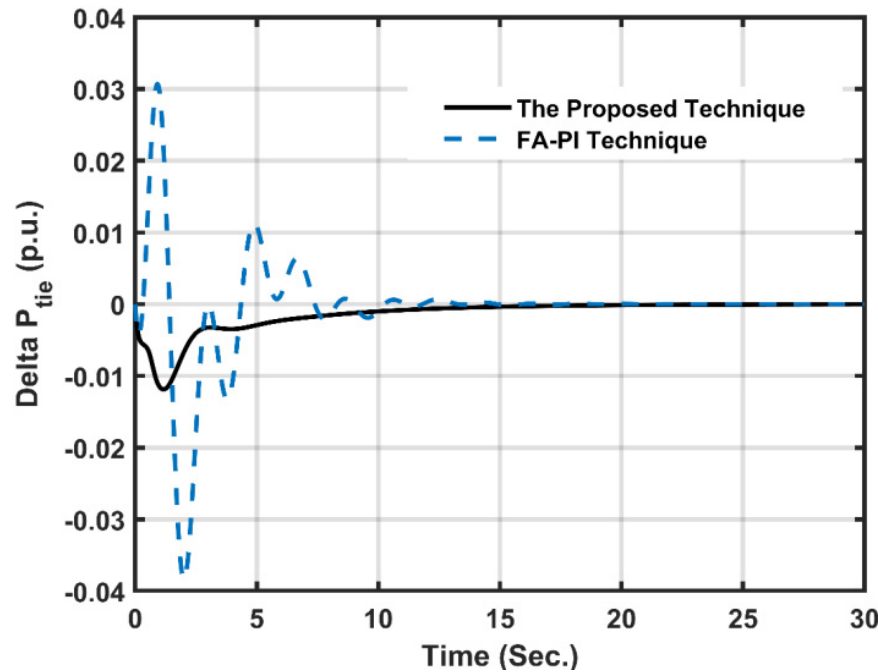
Figure 20. Tie line power deviation under disturbances in thermal and PV demands.